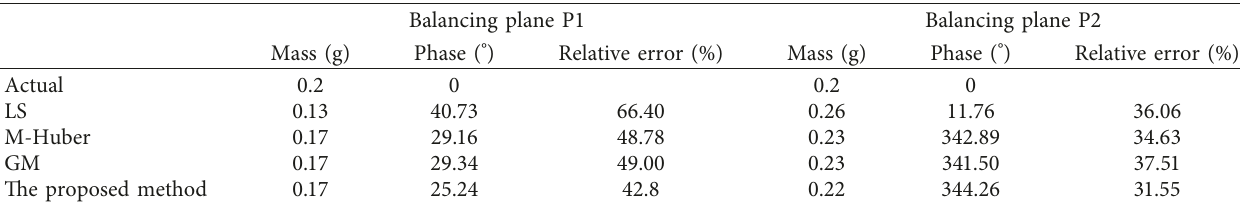
Figure 6: The vibration response of measuring planes A and B. X and Y correspond to the horizontal and vertical direction, respectively. (a) Vibration response of measuring plane A. (b) Vibration response of measuring plane B. Table 2: The results of estimated unbalance masses.